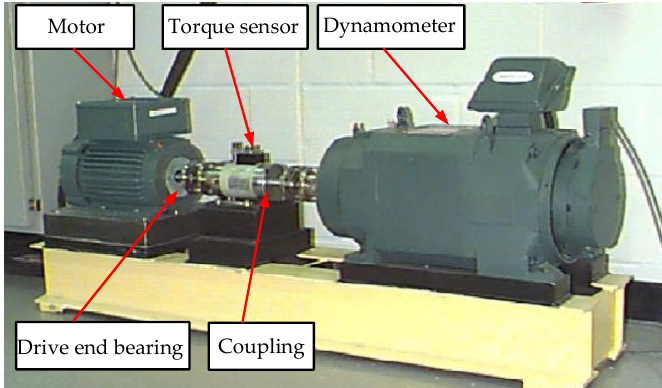
Figure 2. Bearing test bench of CWRU.